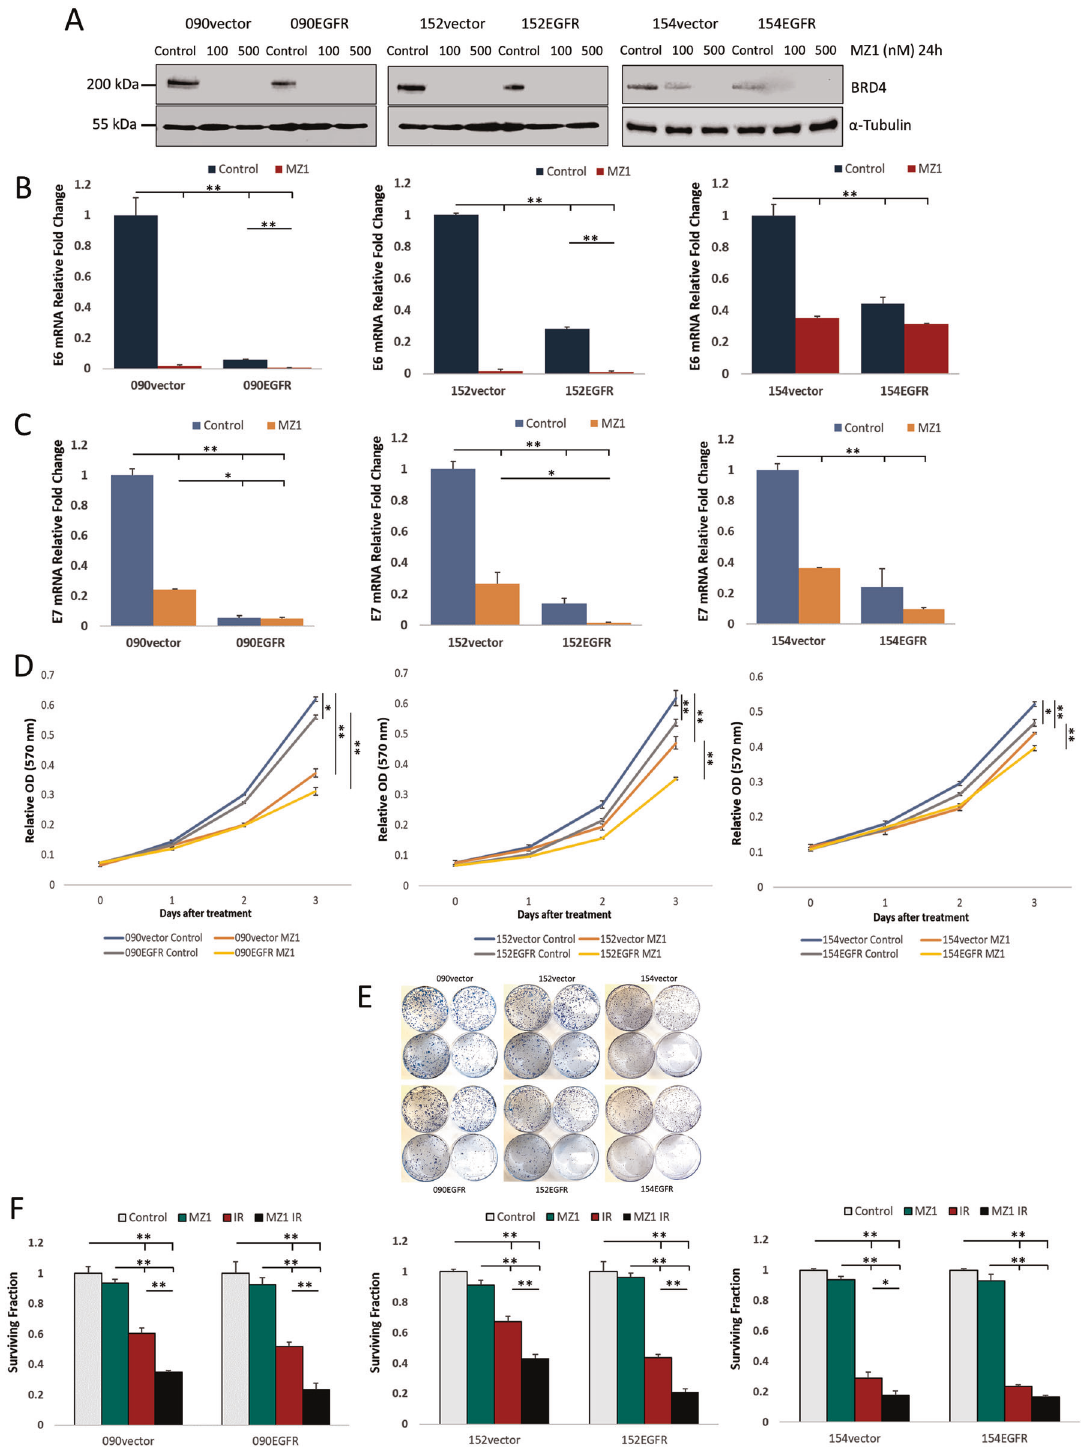
Fig. 5 Effects of BRD4 inhibition using MZ1 inhibitor. A Expression levels of BRD4 in SCC090, SCC152 and SCC154 control cells and their EGFR-overexpressing counterparts as determined by western blot after MZ1 treatment at indicated concentrations for 24 h. B HPV E6 and C HPV E7 transcription after MZ1 treatment (100 nM for 24 h) determined by qRT-PCR in three independent RNA extractions. Statistical analysis was performed by one-way ANOVA (* p < 0.05, ** p < 0.01). D Cell proliferation measured by MTT from day 0-3 treated with MZ1 (100 nM). Statistical analysis was performed using two-way ANOVA (* p < 0.05, ** p < 0.01). E Clonogenicity after 5 Gy irradiation of the HPV- positive control cells and their EGFR-overexpressing counterparts treated with MZ1 prior to irradiation (in each panel, top left- untreated control; top right- MZ1 (100 nM 24 h); bottom left- 5 Gy irradiated; bottom right- MZ1 (100 nM 24 h) with 5 Gy irradiation). F Quanti fi cation of clonogenic survival treated with the same conditions in three independent experiments. Control untreated control, MZ1 MZ1 100 nM 24 h; IR- 5 Gy irradiated; MZ1 IR – MZ1 100 nM 24 h then 5 Gy irradiated. Statistical analysis was performed using one-way ANOVA (* p < 0.05, ** p < 0.01).